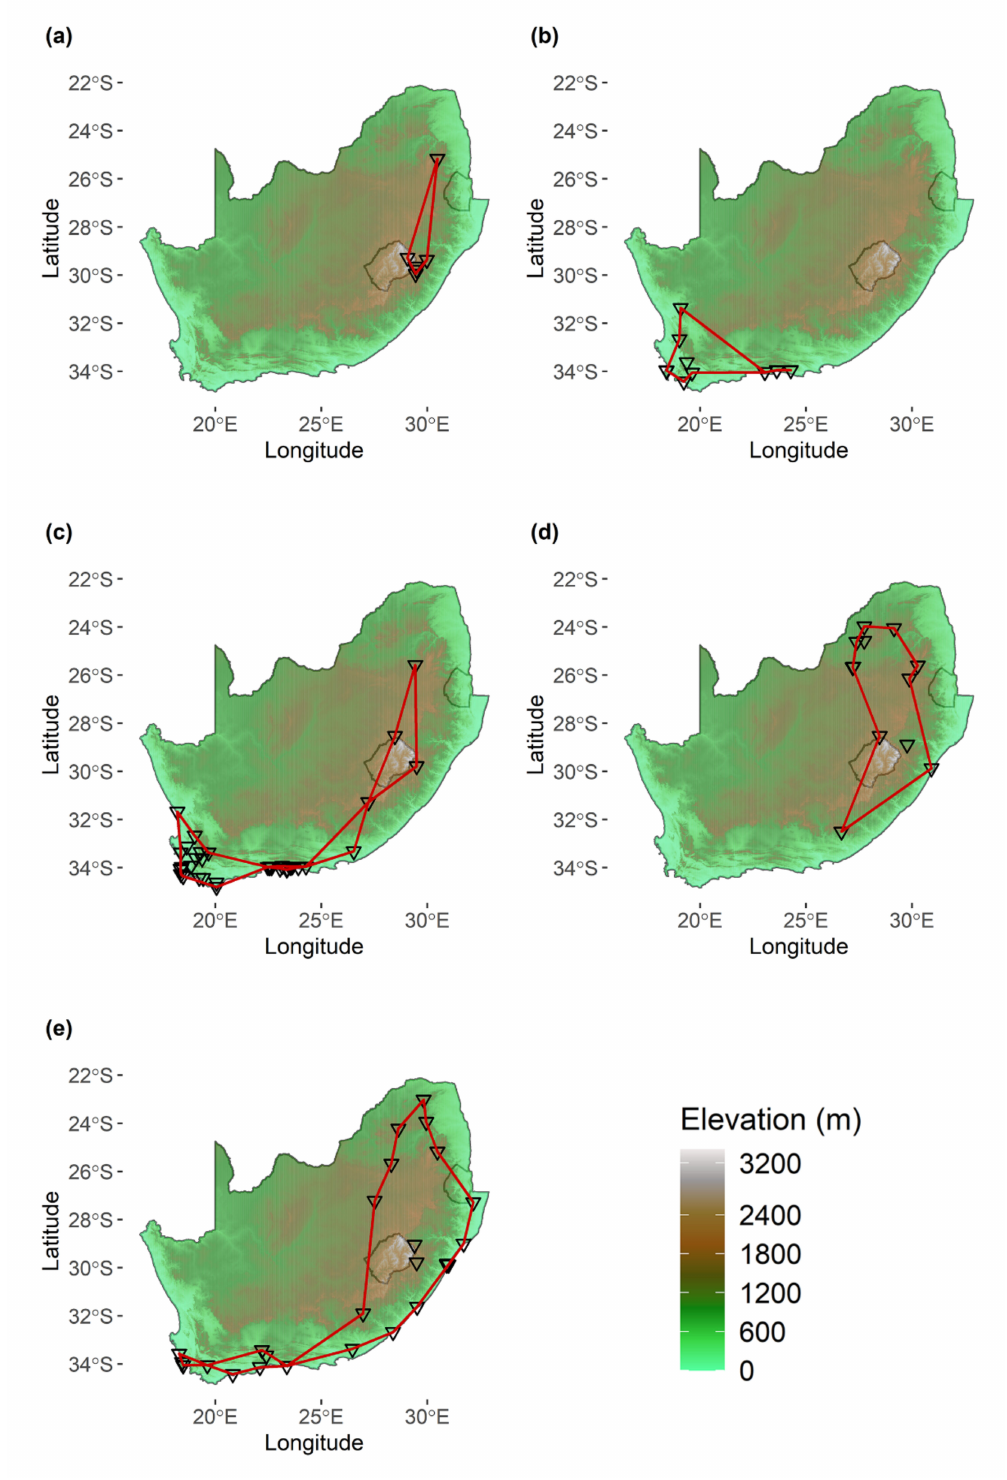
Figure 3. Alphahull-based estimated range (red lines) and occurrence records (reversed black- contoured triangles), overlaid on a DEM map showing altitude values within the study region at 30 arc-seconds (i.e., ~1 km 2 ) cell resolution, for: ( a ) Chaetocnema brincki ; ( b ) C. danielssoni ; ( c ) C. darwini ; ( d ) C. gahani , and ( e ) C. natalensis